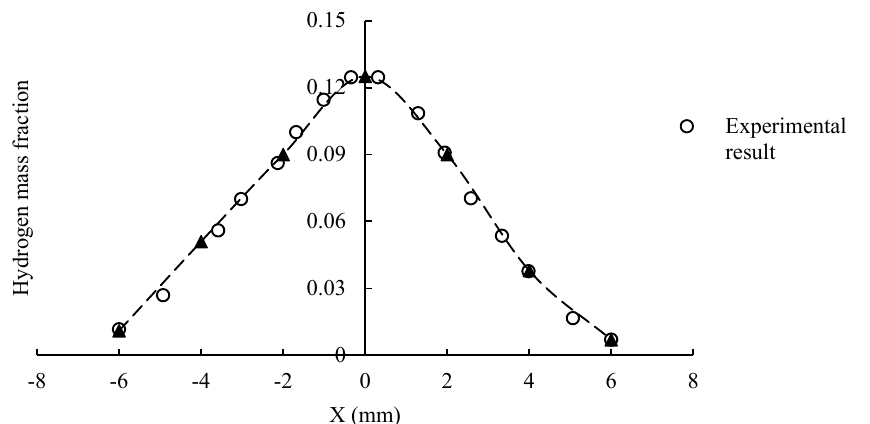
Figure 2. The experimental and simulation results of radial hydrogen mass fraction at Z/D = 10 of hydrogen jet.